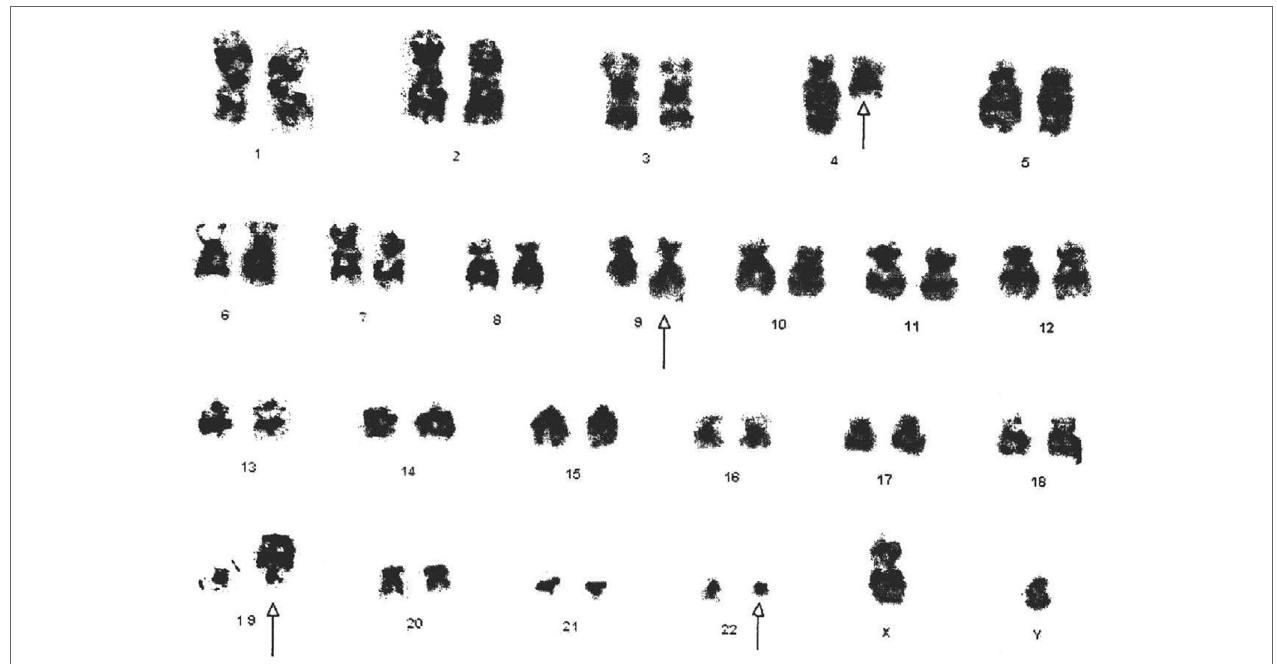
FIGURe 1 | Cytogenetic analysis shows the karyotype of the CML patient with 46,XY,t(4;9;19;22)(q25:q34;p13.3;q11.2) . All derivative chromosomes are highlighted by arrow